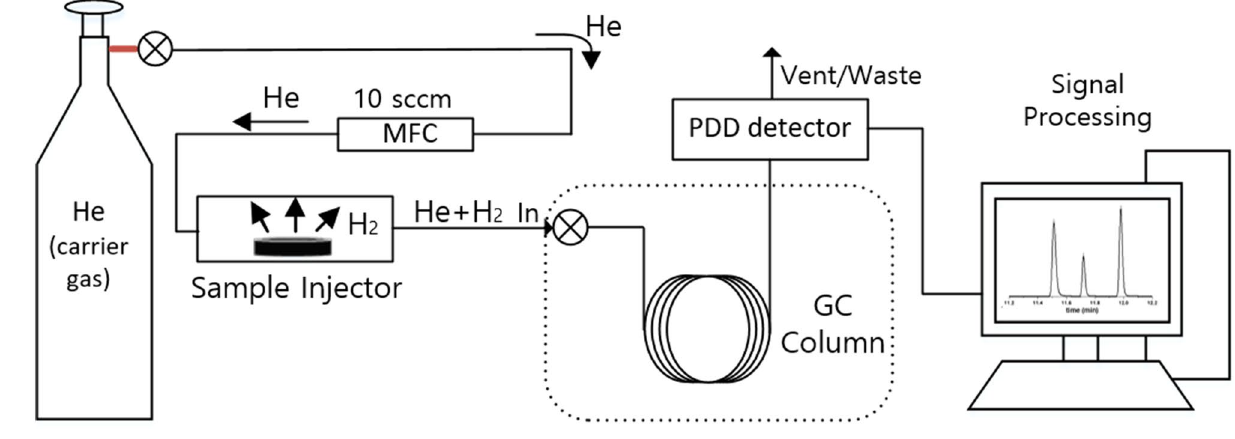
Figure 1. Configuration of the TDA-GC setup.